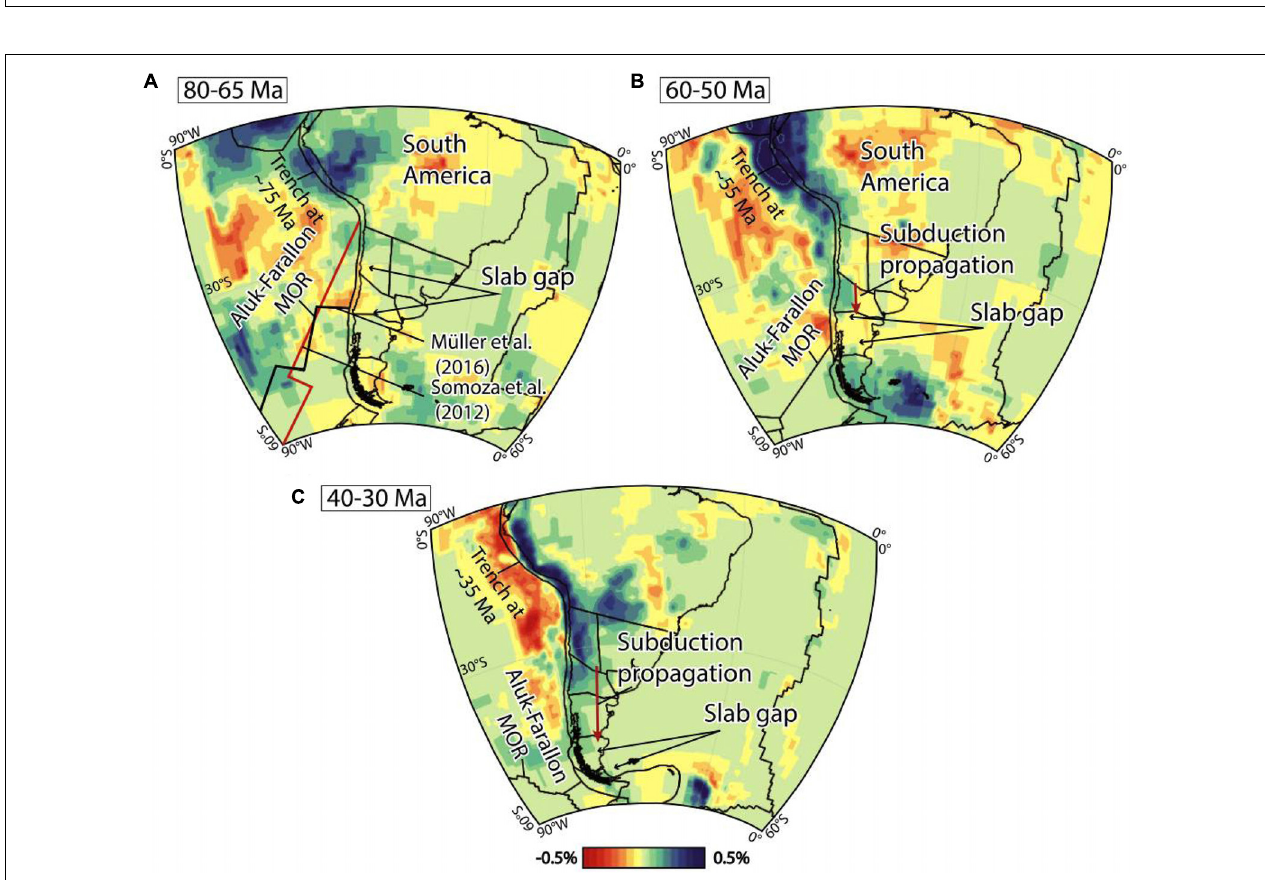
FIGURE 9 | Tomography slices at a depth of 1200 km from global P-wave (PRI-05; Montelli et al., 2006; GAP-P04, Obayashi et al., 2013) and S-wave (SPani-P, Tesoniero et al., 2015) seismic tomography models showing the mantle structure corresponding to subduction in Late Cretaceous ( ∼ 80–70 Ma).